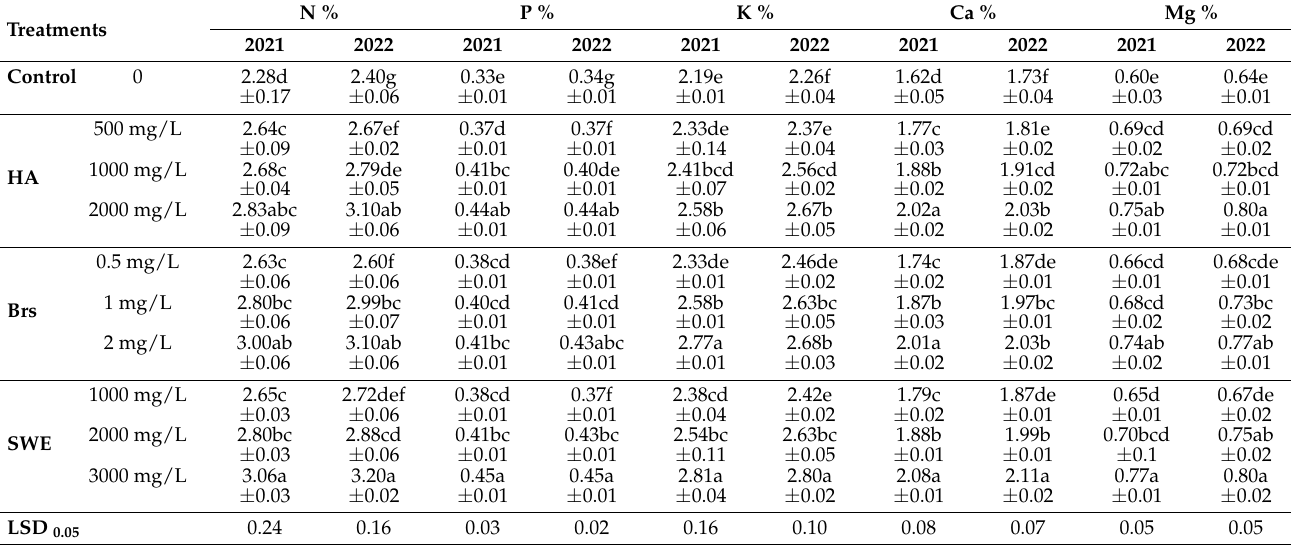
Table 9. Effect of foliar spraying of HA, Brs, and SWE on the leaf mineral content of macronutrients of apricot cv. Canino during 2021–2022.